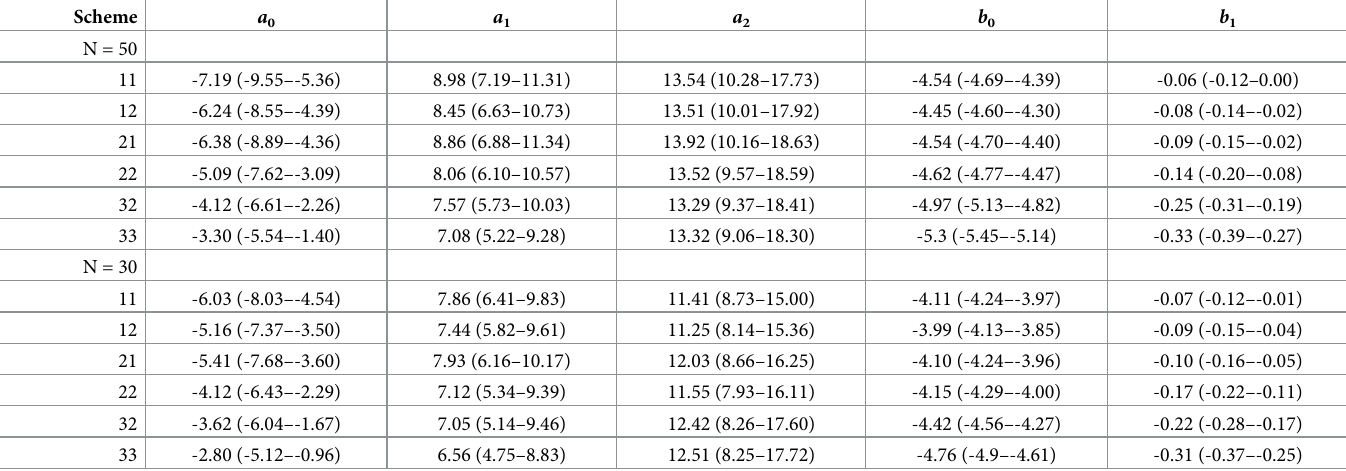
Table 2. Posterior estimates (mean and 95% BCI) of the parameters describing the relation between geometric mean of the total population and sensitivity for six sampling schemes and two sample. The mean estimate for the ‘true’ prevalence is calculated by p ¼ p obs = logit (cid:0) 1 ð a intensity μ in eggs-per-slide (EPS) is known. The probability distribution of the ‘true’ prevalence is given by Beta( α , β ), where α = p / ν , β = (1 − p )/ ν , and ν = exp( b 0 + b 1 log g ( μ g )).